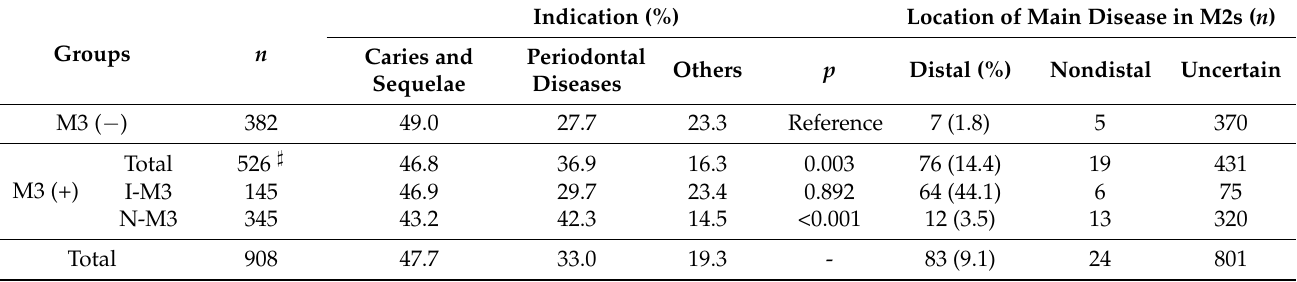
Figure 2. Reasons for M2 extraction in 908 quadrants. Table 3. Reasons for M2 extraction in quadrants with the absence or presence (impacted/erupted) of neighboring M3s ( n = 908).